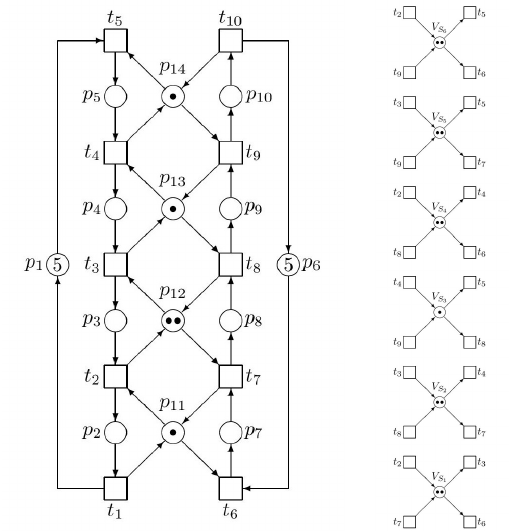
Figure 10. The unsupervised PN model together with its supervisor.